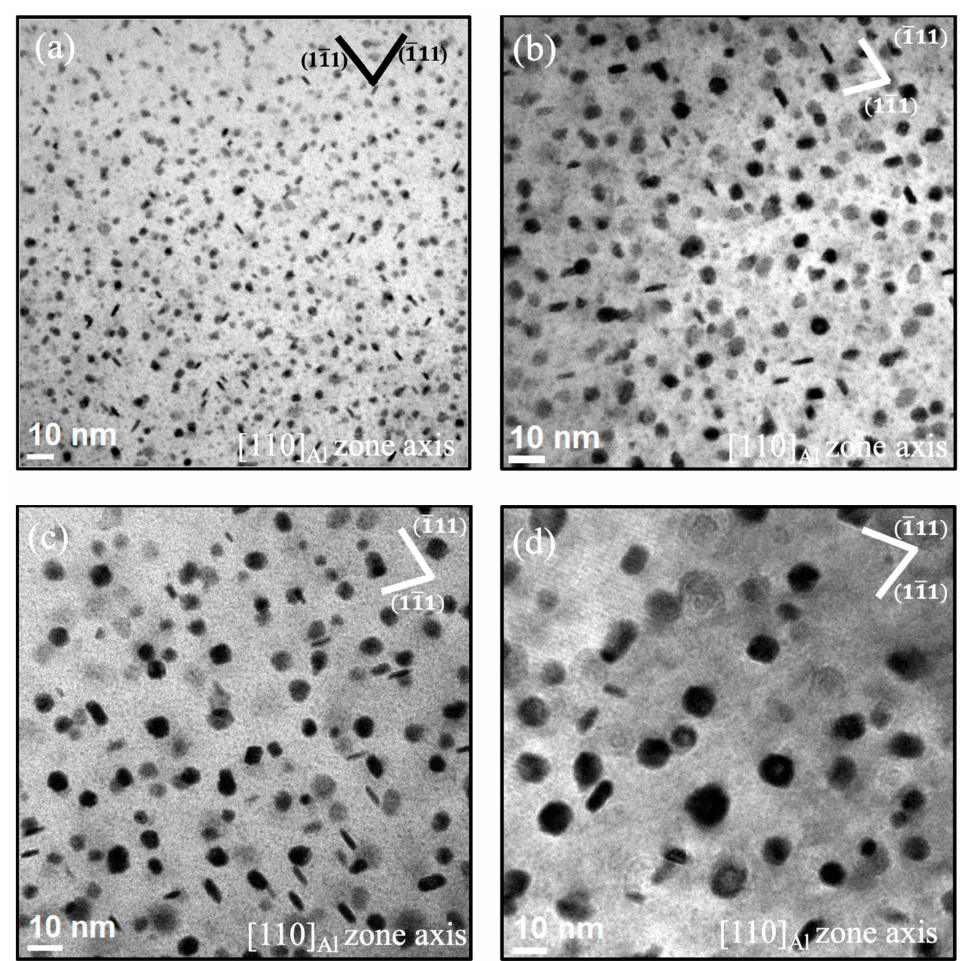
Figure 5. TEM images of η (cid:48) precipitates of 7075-HCu obtained from the PA conditions at ( a )100 ◦ C,